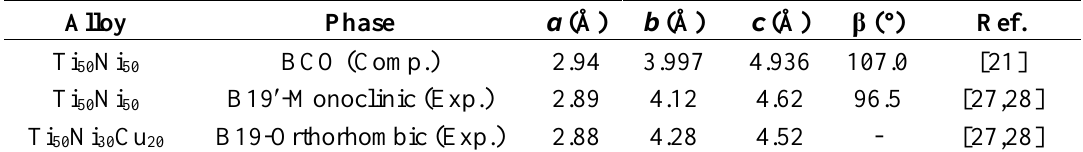
Table 1. Lattice parameters of B19, B19′ and base-centered orthorhombic (BCO) from previous experimental and theoretical